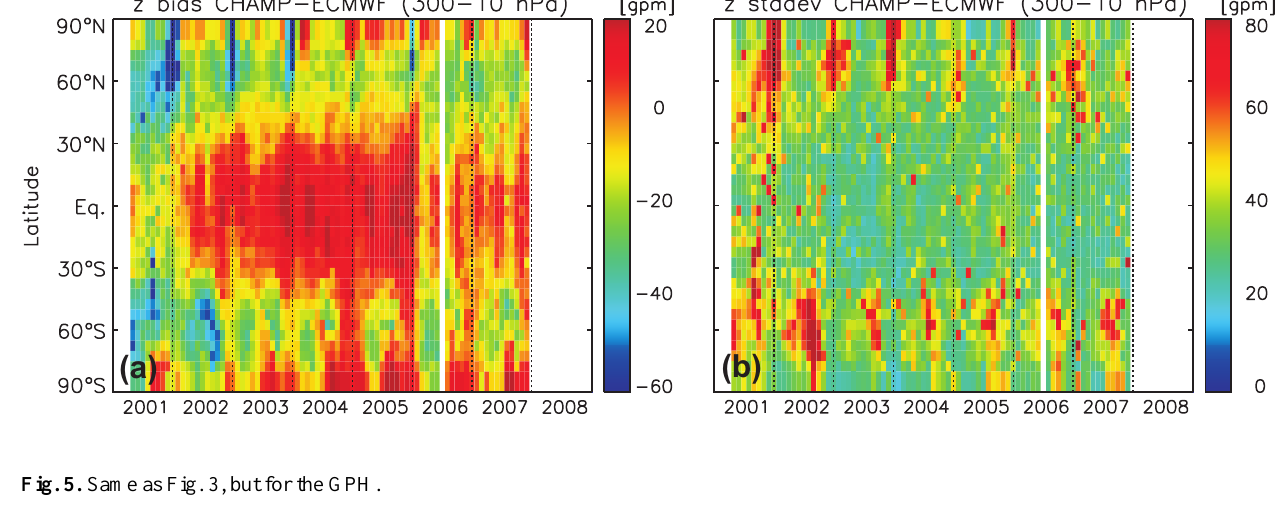
Fig. 5. Same as Fig. 3, but for the GPH.